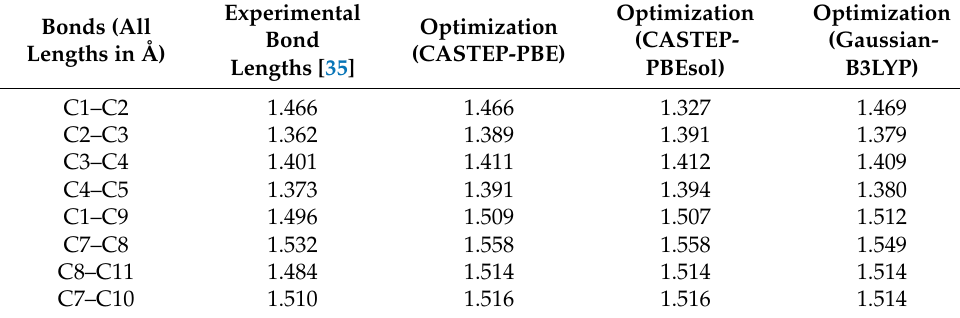
Table 3. Optimized bond lengths C-C of the C 10 H 13 BO 3 S compound.